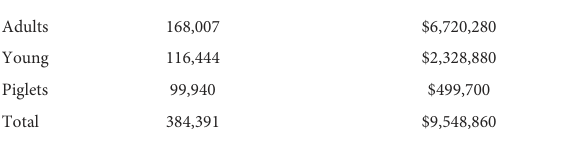
TABLE 1 Summary of pigs (a) killed and compensation paid during slaughter from 1981 to 1984 as part of the PEPPADEP campaign in